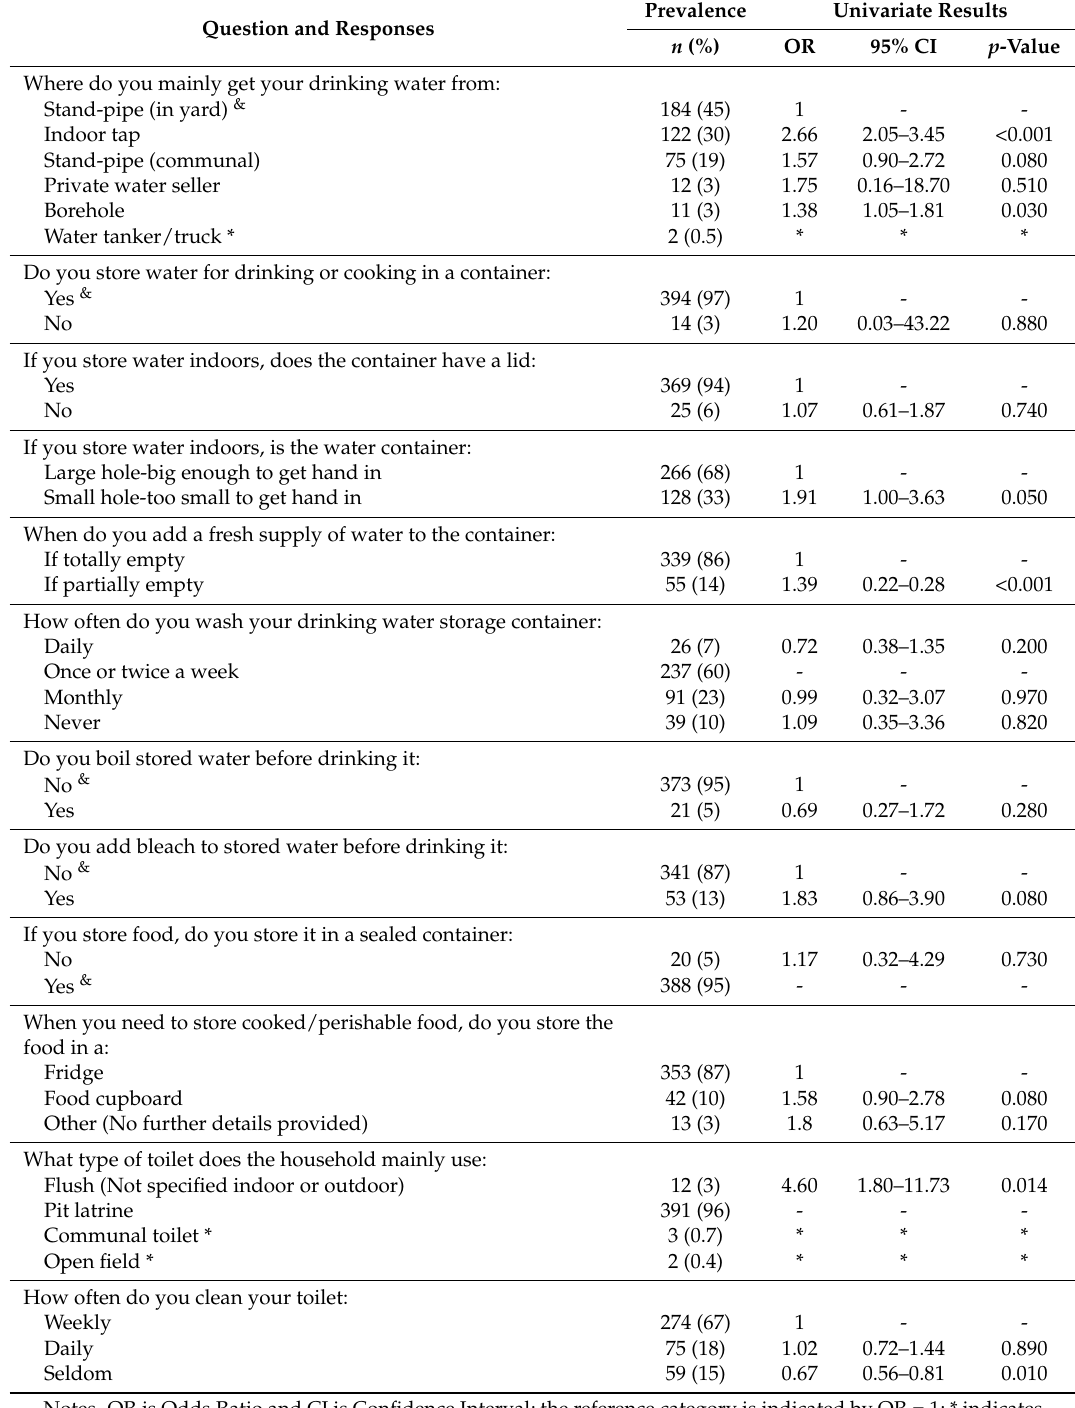
Table 2. Results of univariate logistic regression for household risk factors in relation to household diarrhoea prevalence. Question and Responses